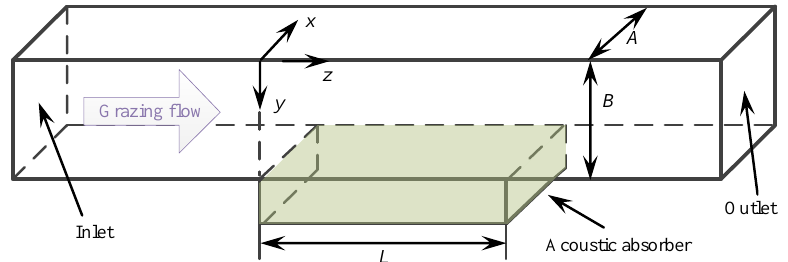
Figure 1. Schematic diagram of the rectangular duct – acoustic absorber system under grazing flow.